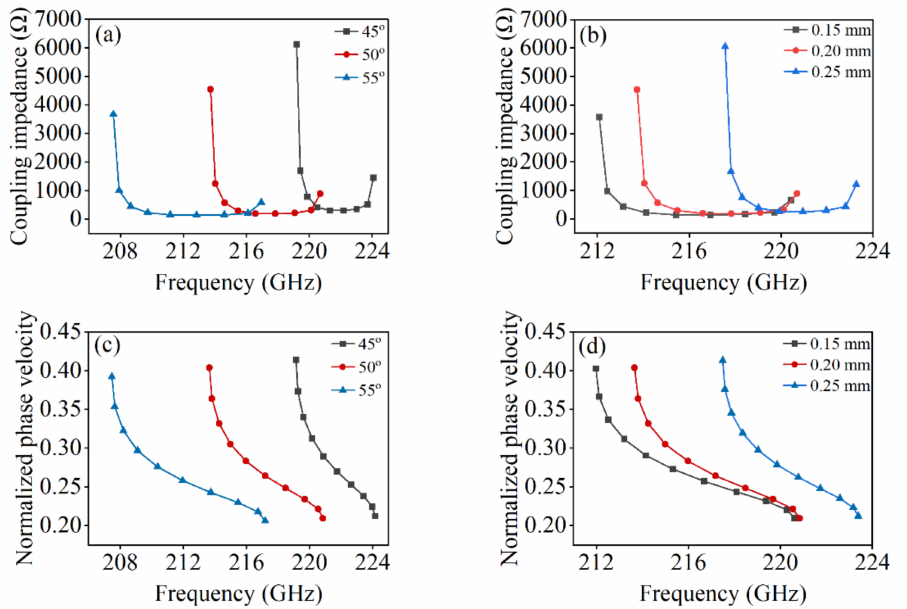
Figure 4. ( a ) The coupling impedance as a function of coupling hole angle when h is 0.2 mm. ( b ) The coupling impedance as a function of coupling hole height when θ is 50 ◦ . ( c ) The normalized phase velocity of the coupling hole with different angles when h is 0.2 mm. ( d ) The normalized phase velocity of the coupling hole with different heights when θ is 50 ◦ .